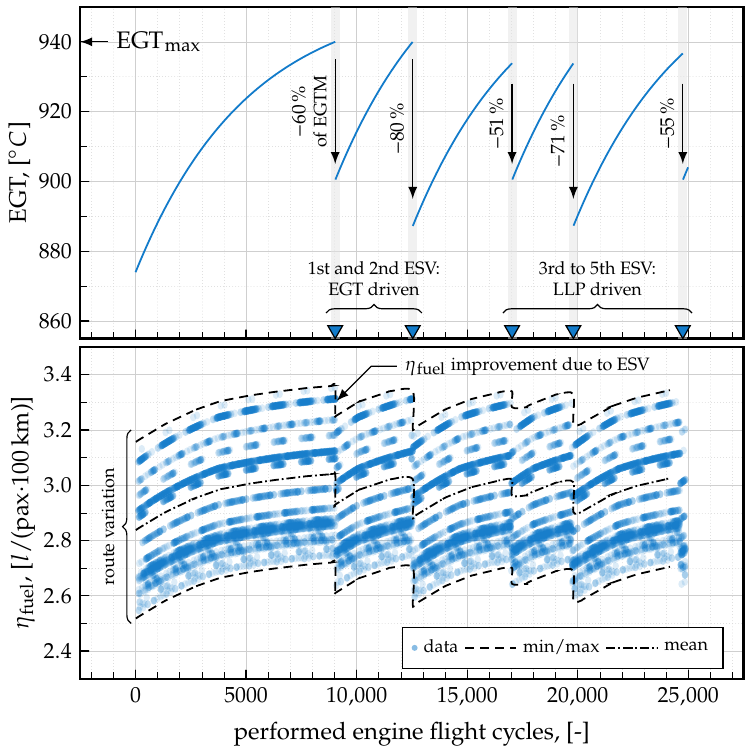
Figure 17. Development of Exhaust Gas Temperature (EGT) ( top ) and fuel efficiency ( bottom ) of the reference case, i.e., without Engine